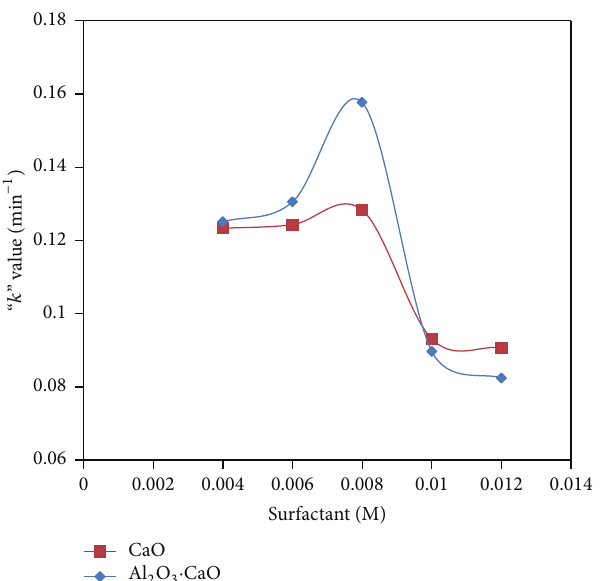
Figure 14: Plot of surfactant concentration versus rate constant “ 𝑘 ” of the degradation of 2,4,6-TNP.